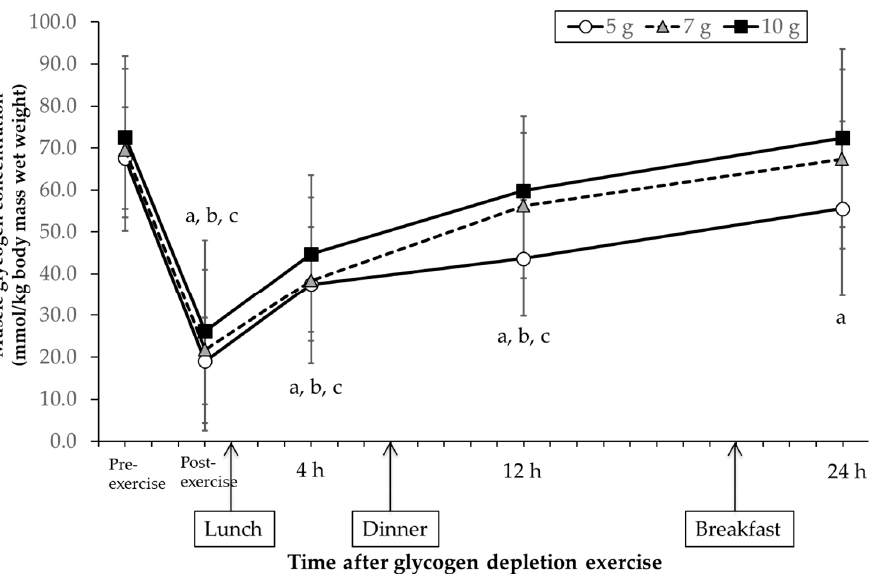
Figure 2. Changes in muscle glycogen concentration over 24 h for the three carbohydrate intake amounts—a: 5 g group, b: 7 g group, c: 10 g group, vs. pre-exercise; p < 0.05; values are expressed as mean ± standard deviation.